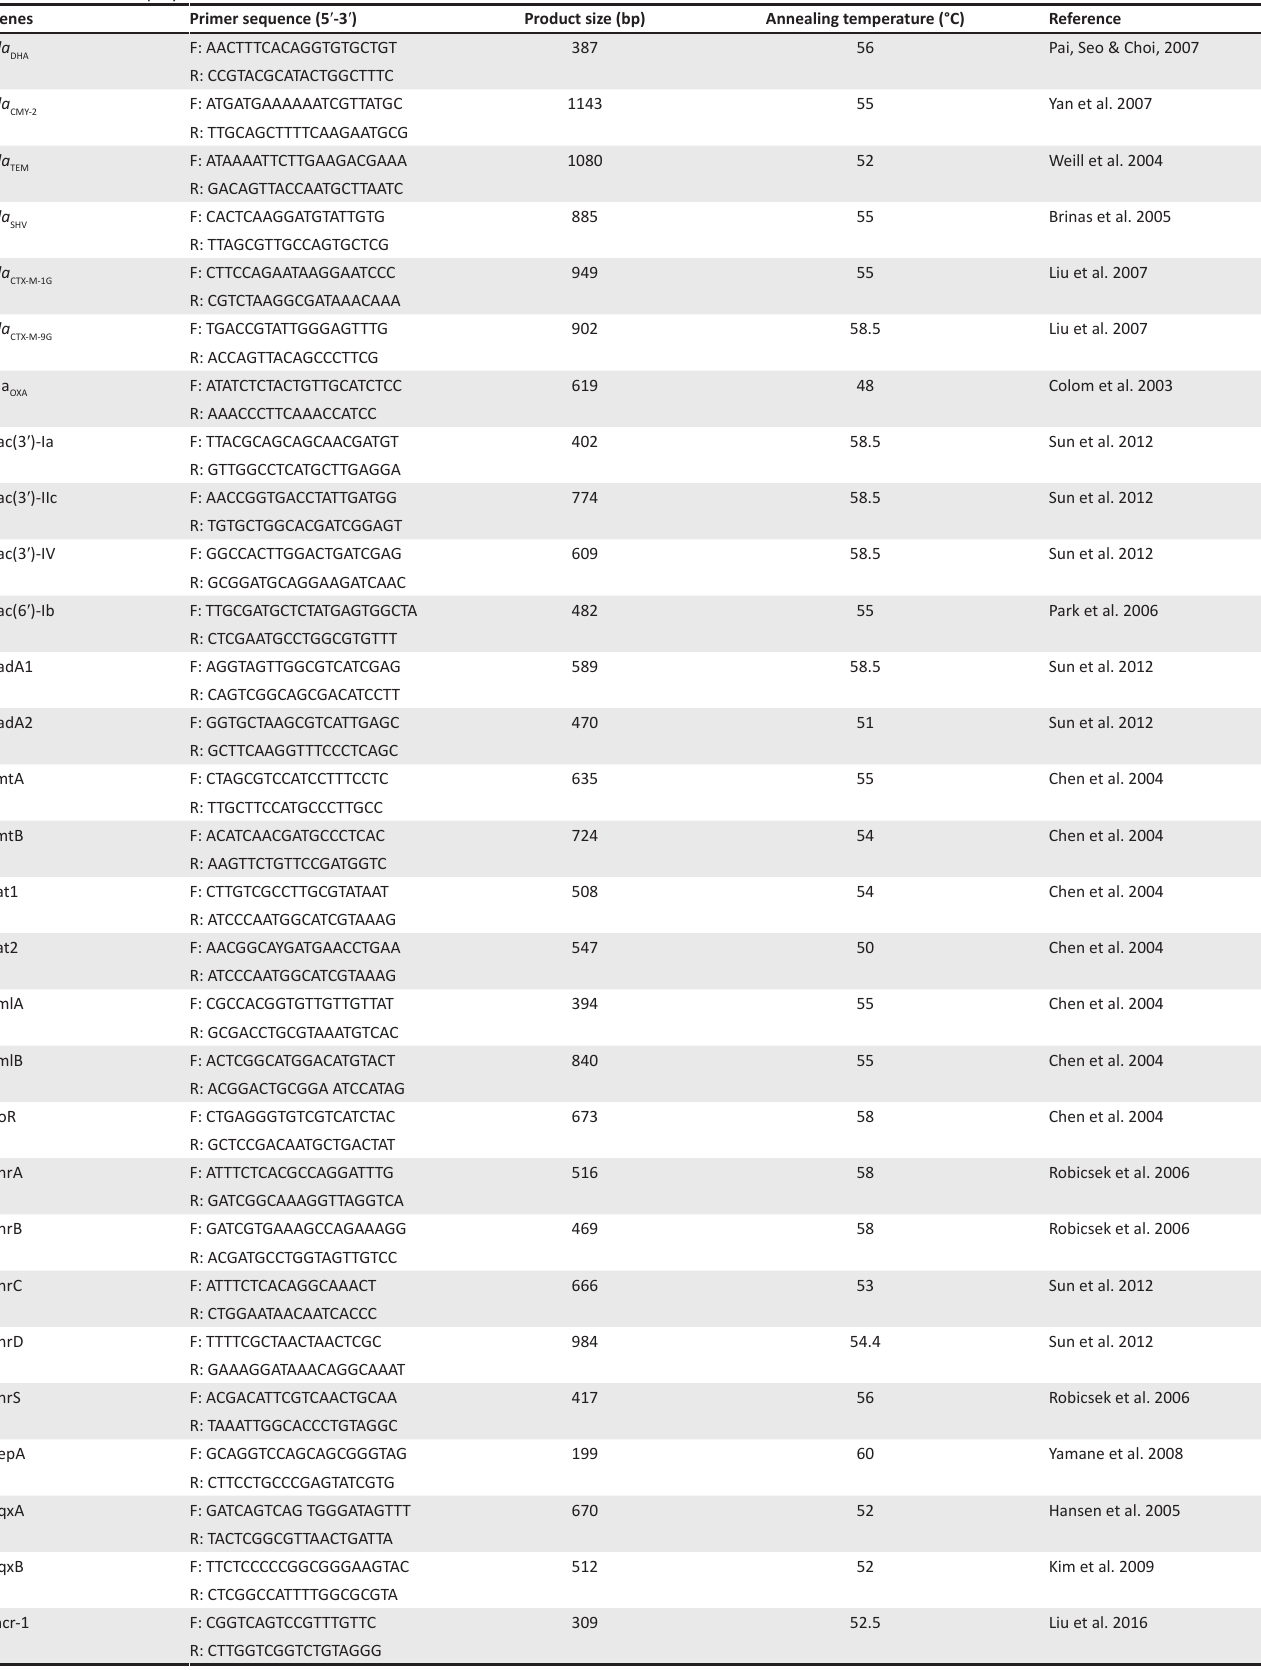
TABLE 1: Primers for polymerase chain reaction.